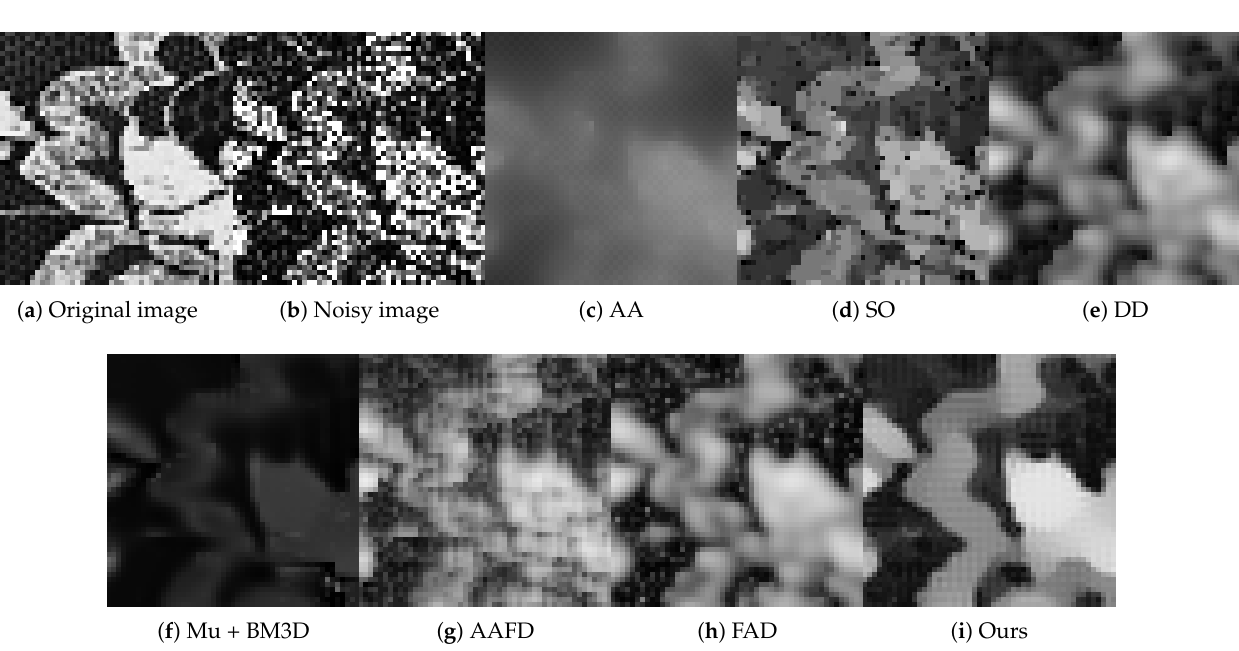
Figure 9. The zoomed version of the D4 image and its corresponding denoised